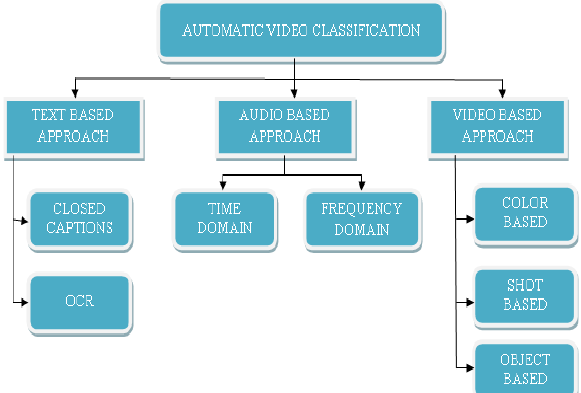
Figure 1. Automatic video classification